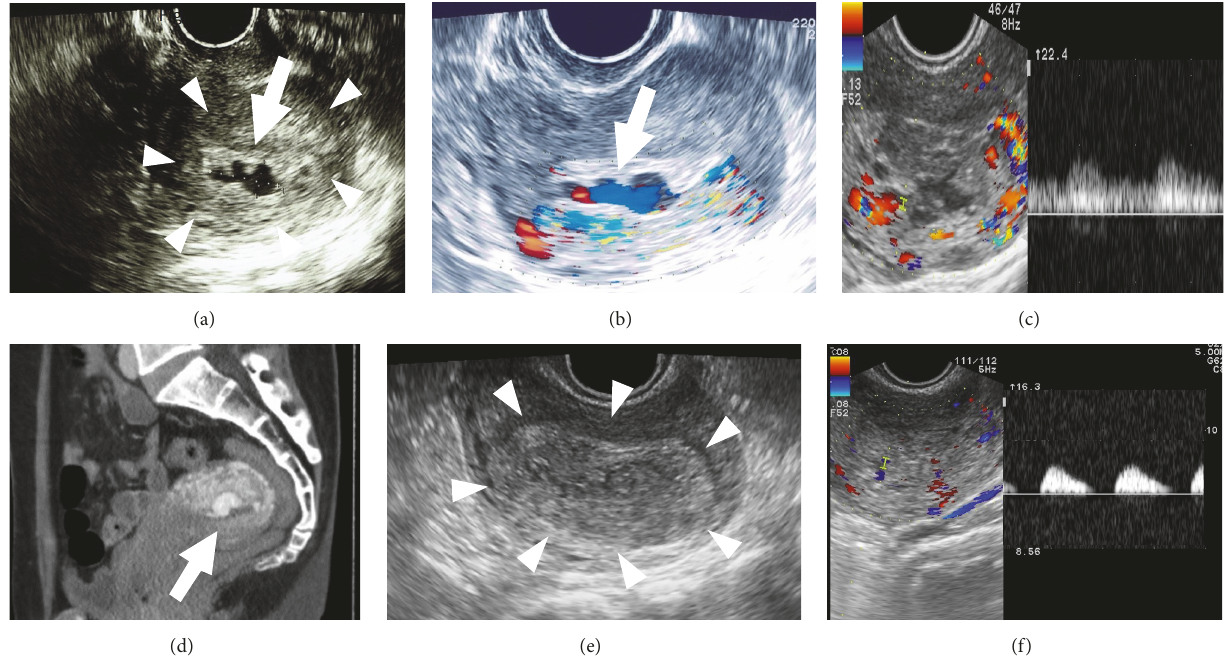
Figure 1: Findings of gray-scale ultrasound (a, e), Color Doppler (b), left panels of (c) and (f), Pulse Wave Doppler (right panels of (c) and (f)), and multiphase computed tomography (d). Images were taken on the first day of hospitalization (day 36 after vaginal termination) for (a)–(d) and day 55 for (e) and (f). (a) A low-echoic mass (arrow: size of 24 × 10mm and indicative of an intrasac free lumen) is observed in the uterus, which is surrounded by a high-echoic mass (encircled by arrowheads: indicative of hematoma/thrombus). (b) Swirling blood flow (arrow) in the uterine cavity. (c) Swirling blood flow with arterial waveforms on Pulse Wave Doppler. At this stage, diastolic flow is evident. (d) An enhanced mass, measuring 24 mm in diameter, suggestive of a uterine artery pseudoaneurysm (arrow). (e) A high-echoic mass (arrowheads) is present but without an evident low-echoic mass. (f) Diastolic flow is absent on Pulse Wave Doppler, referred to as “absent diastolic flow” of the sac. This pattern was also confirmed by setting the “low-cut filter” lower. This “absent diastolic flow” was observed repeatedly and was also reproducible when the various scanning angles were